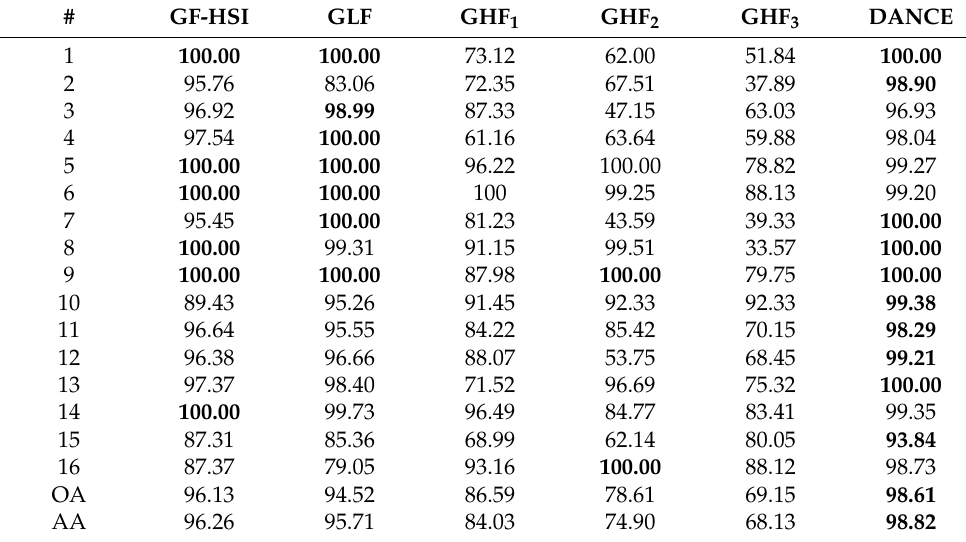
Table 8. Comparison of classification results (%) using DRCNN with different inputs on Indian Pines data.